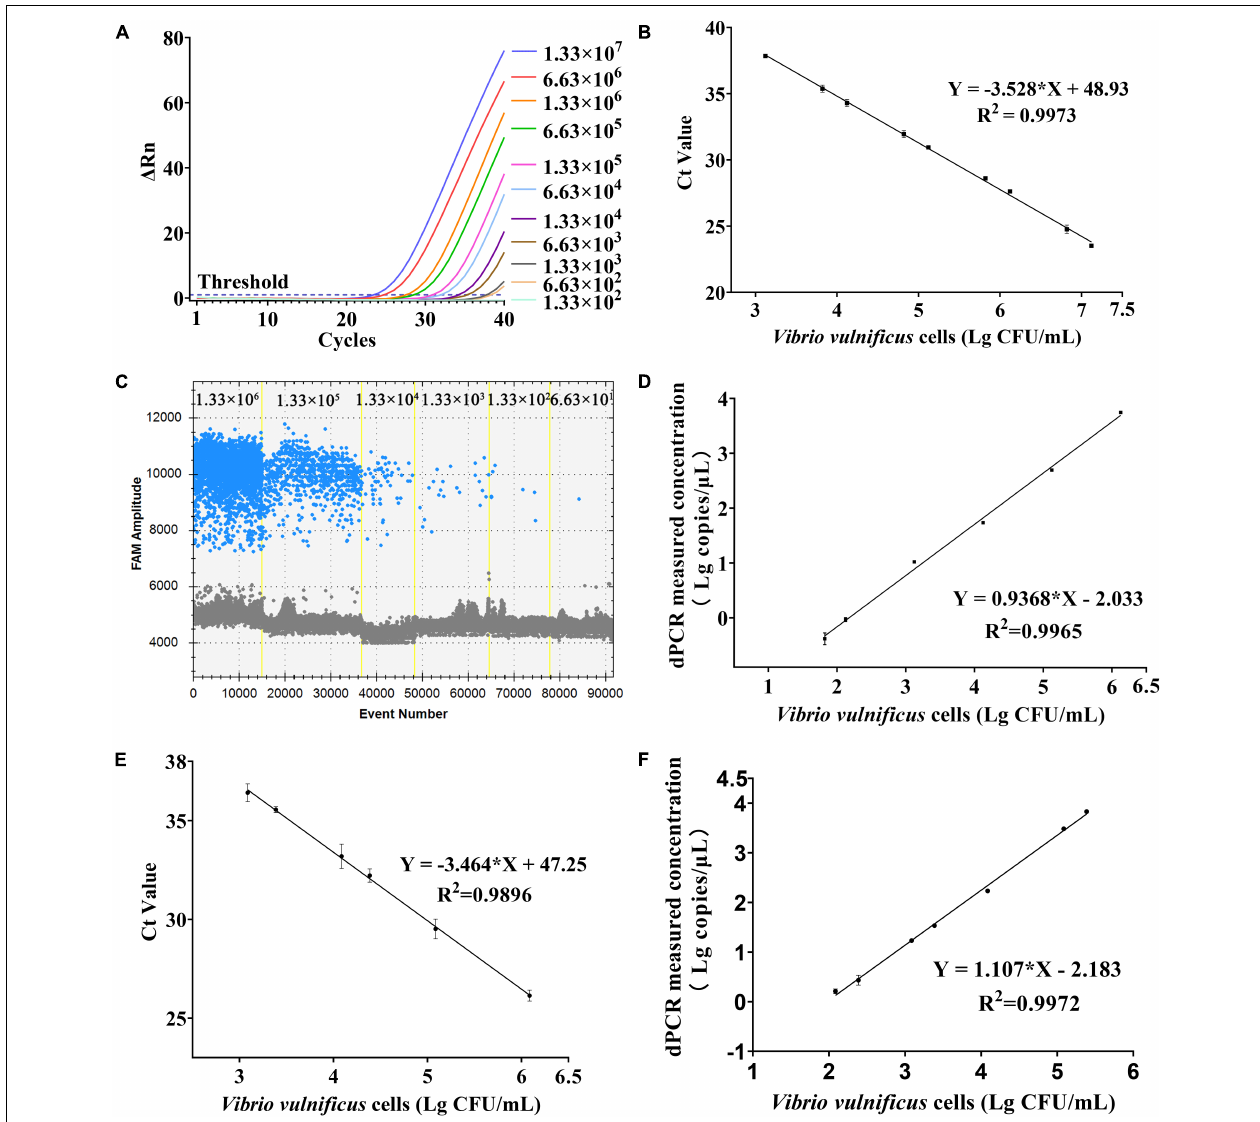
FIGURE 4 | Sensitivity and regression analysis of PMA-qPCR and PMA-ddPCR. (A) Amplification curves of different concentrations of V. vulnificus from pure culture on qPCR. (B) Linear regression analysis based on qPCR in pure culture solutions. Error bars represent the standard deviation based on three replicates. (C) Picture of FAM channel from different concentrations of V. vulnificus in pure culture on ddPCR. (D) Linear regression analysis based on ddPCR in pure culture solutions. Error bars represent the standard deviation based on three replicates. (E) Linear regression analysis based on qPCR in plasma samples. Error bars represent the standard deviation based on three replicates. (F) Linear regression analysis based on ddPCR in plasma samples. Error bars represent the standard deviation based on three